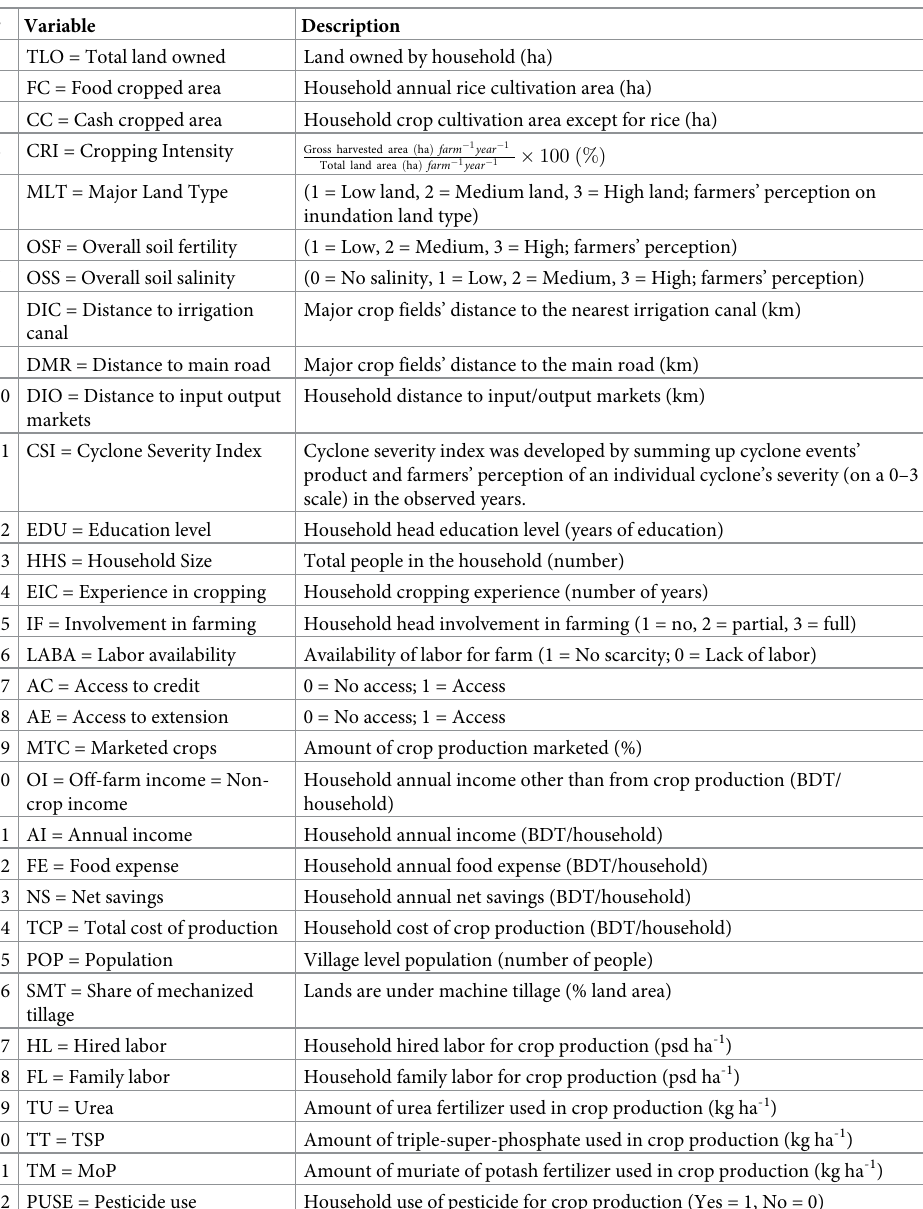
Table 1. Independent variables included in this study 1 .